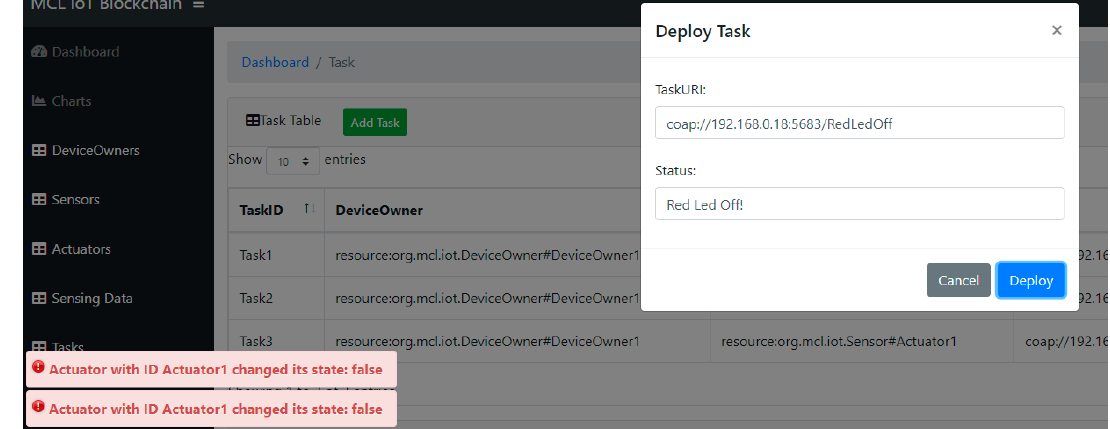
Figure 13. Snapshot of task dashboard.